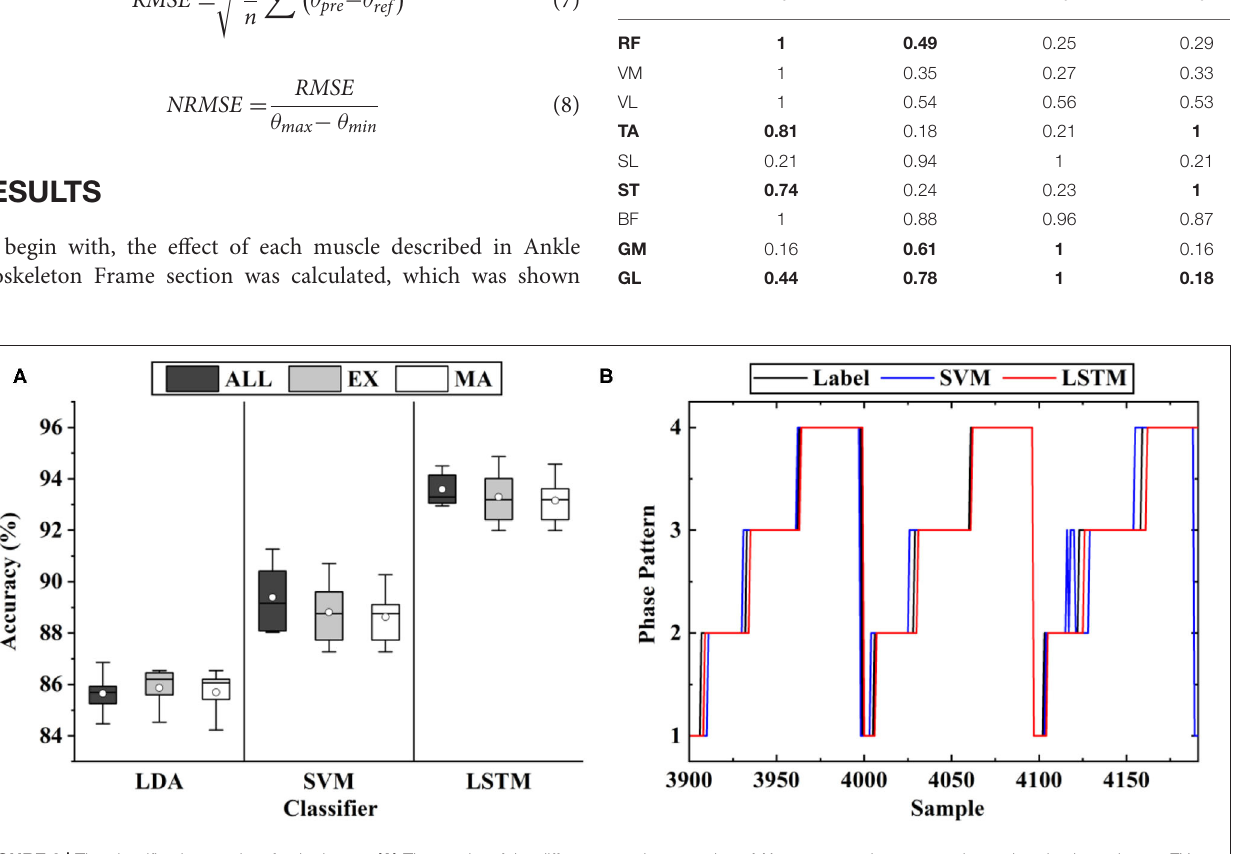
Frontiers in Neurorobotics |